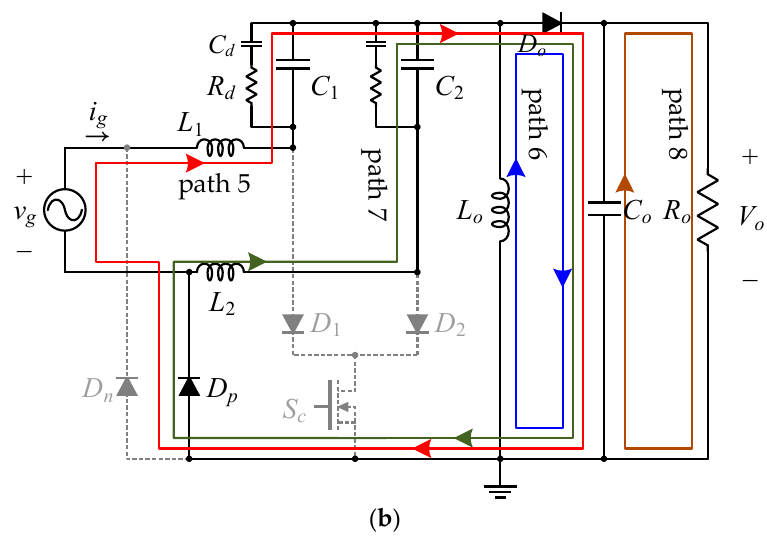
Figure 2. Operation modes of the bridgeless SEPIC PFC converter under positive voltage cycles: ( a ) when S c is turned on; ( b ) when S c is turned off.